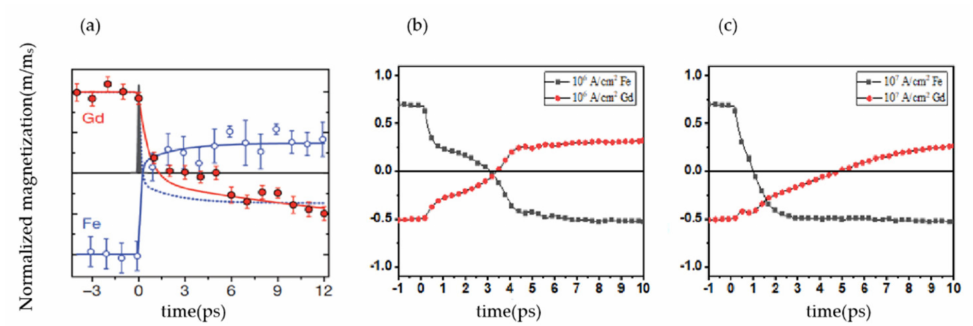
Figure 6. Comparison of normalized magnetization changes between experimental results and simulation results. ( a ) The experiment results performed by a single pulse of 60 fs and a wavelength of 800 nm in Gd 25 Fe 66.6 Co 9.4 alloy, and the laser power density is 4.4 mJ/cm 2 ; ( b , c ) the simulation results considering spin transfer torque